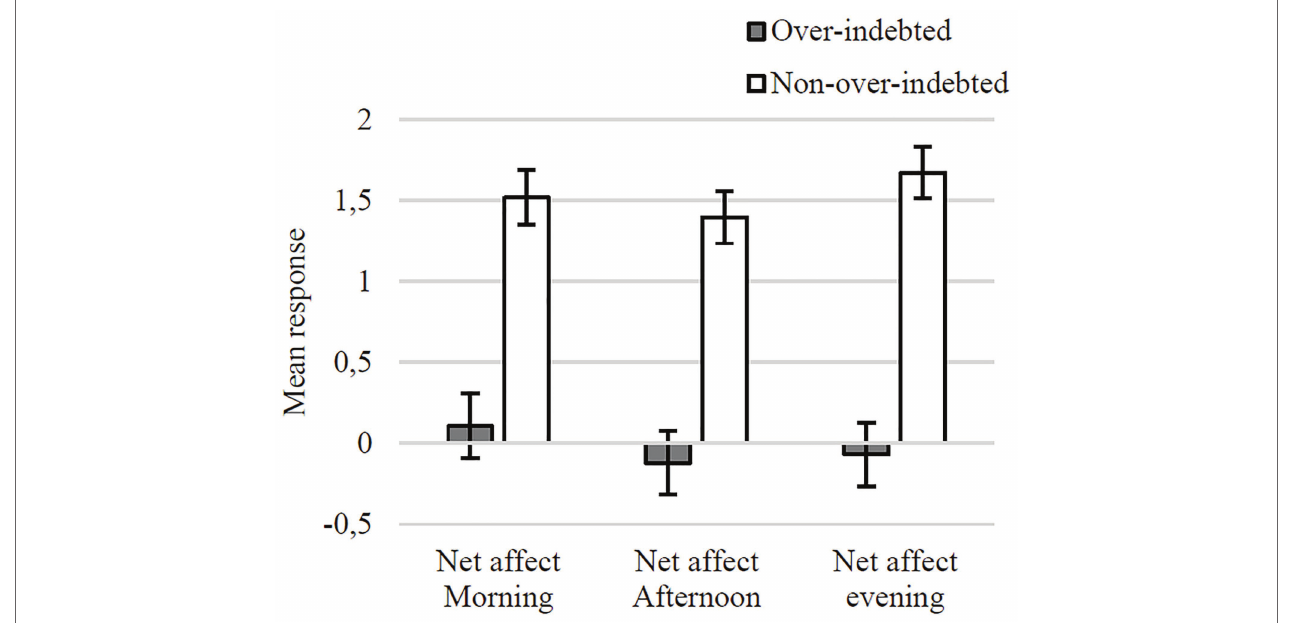
FIGURE 2 | Mean evaluations of net affect on the previous day (with SEs) in over-indebted and non-over-indebted